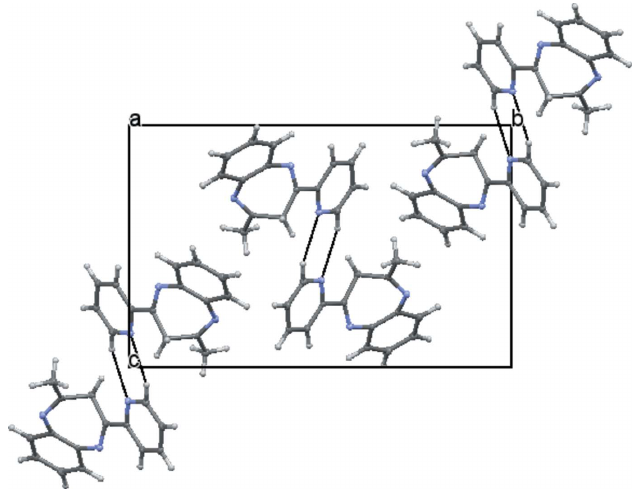
Figure 2 Packing viewed along the a -axis direction with C—H (cid:2)(cid:2)(cid:2) O hydrogen bonds shown as dashed